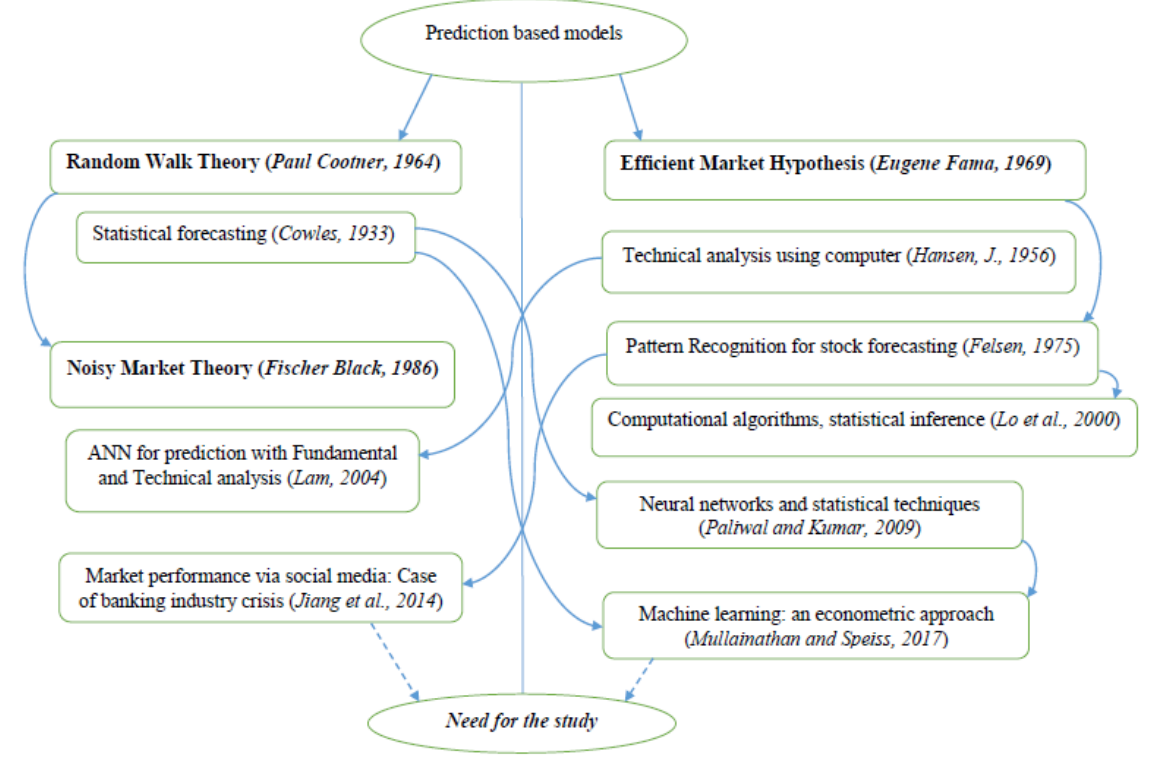
Fig. 1. Literature map (created by the